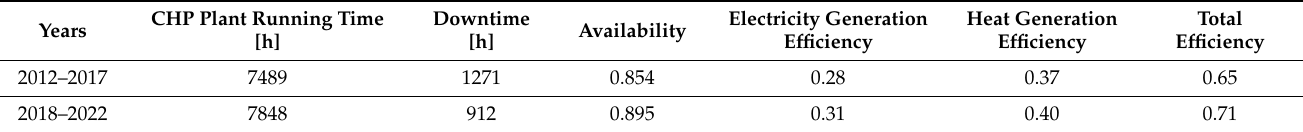
Table 4. CHP plant performance data for